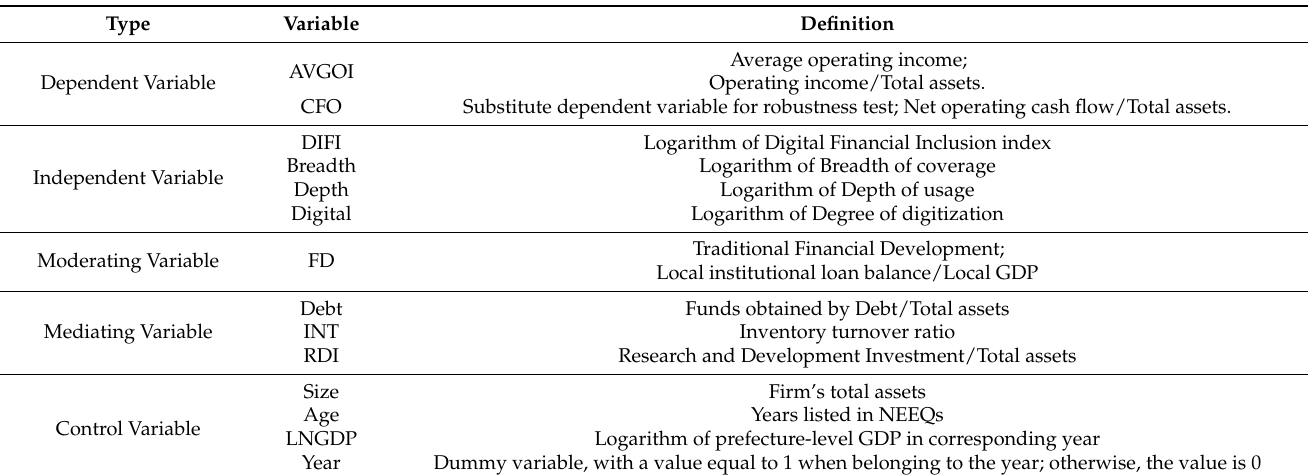
Table 1. Definition of